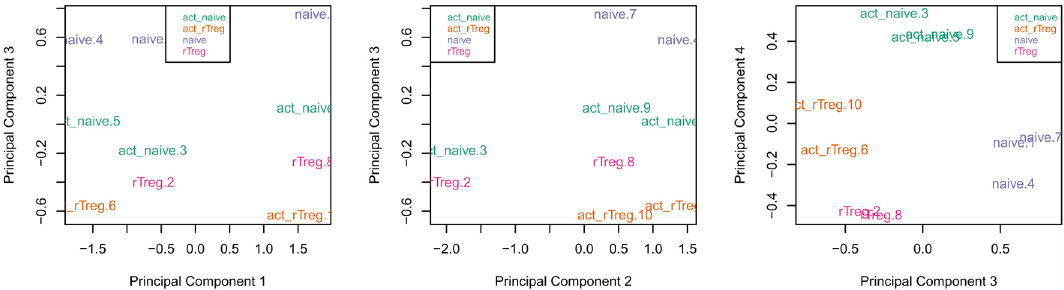
Figure 5. Examining the higher dimensions of an MDS plot can reaveal significant sources of variation in the